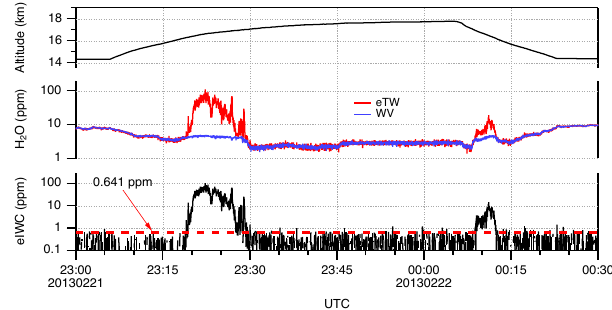
Figure 12. Time series of measured H 2 O vapor (WV) and enhanced total water (eTW) including two cloud encounters during a vertical profile maneuver through the TTL during the flight of 21–22 Febru- ary 2013. The top section shows the aircraft altitude. The middle section shows the measured H 2 O vap (blue) and eTW (red) mixing ratios. The bottom section shows the calculated enhanced ice water content, eIWC ( = eTW − H 2 O vap ) . The dashed red line indicates the detection threshold for eIWC of 0.641ppm determined from the precision (2 σ) in the difference between the two channels during cloud-free sampling.